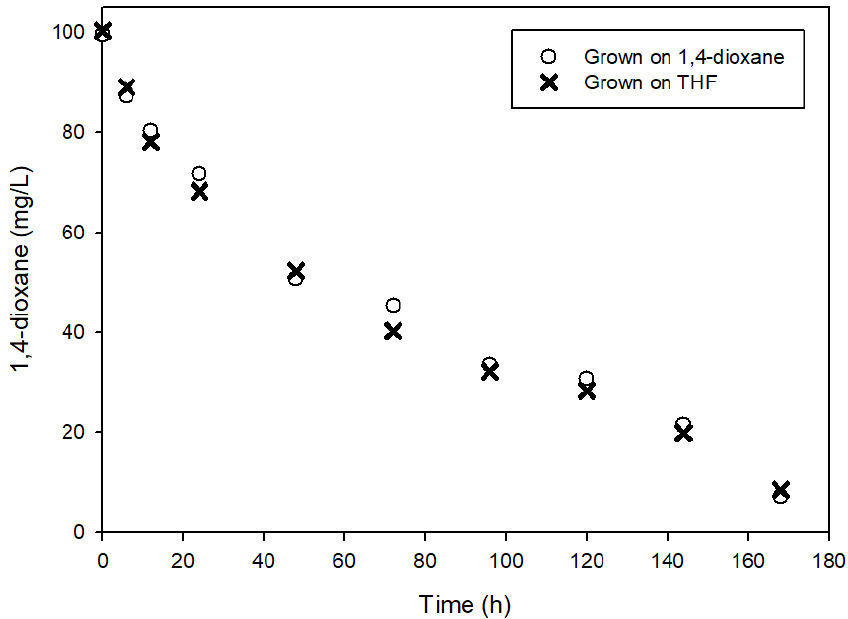
Figure 9. Biodegradation of 1,4-dioxane by cultures pre-grown on THF and 1,4-dioxane.